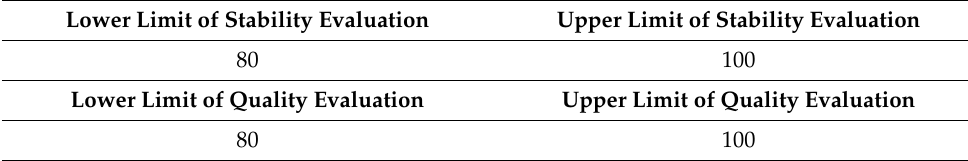
Table 3. Specification range